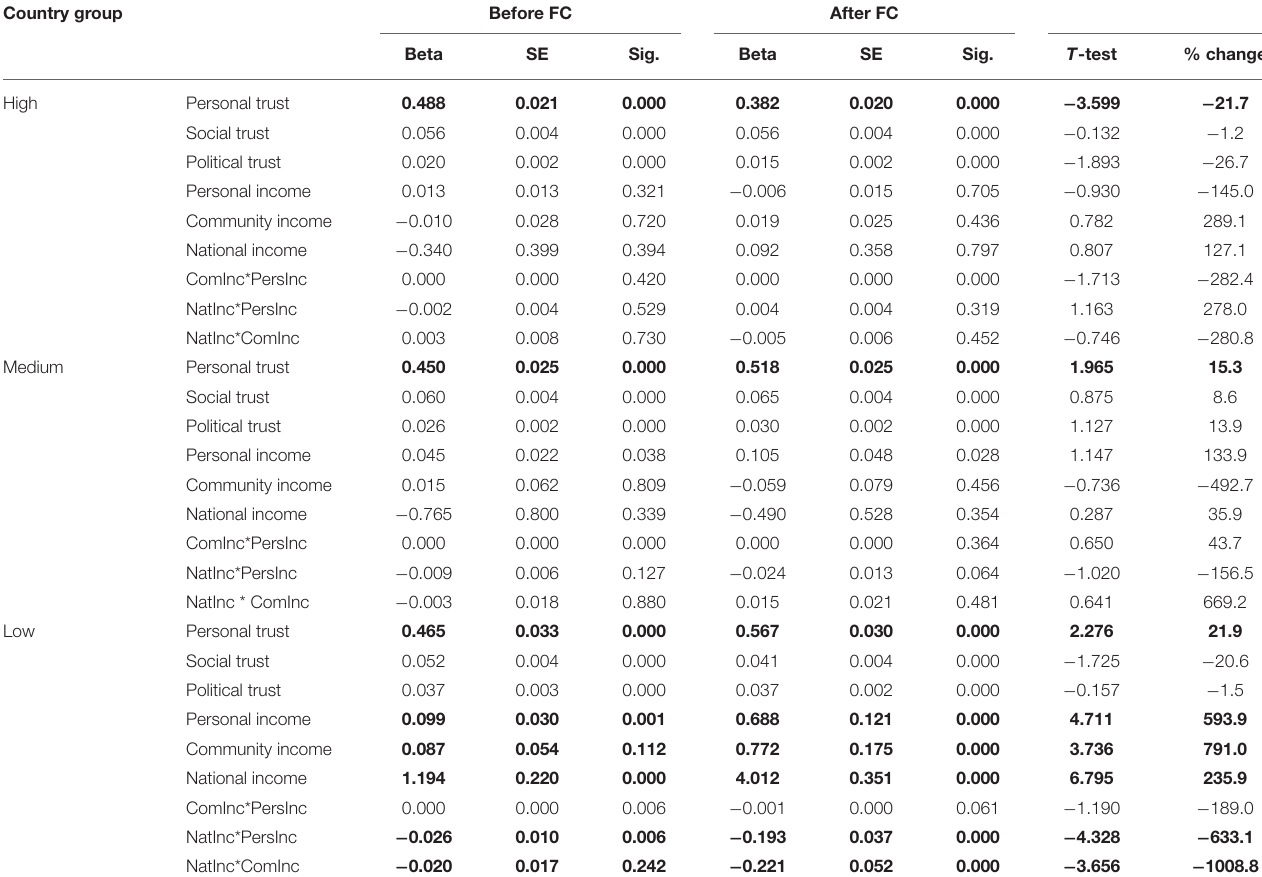
TABLE 4 | Unstandardized beta in a multilevel linear relationship of personal LS, before and after the financial crisis of 2008/2009, as a function of demographic, income, and trust parameters in each of the three groups of countries stratified by an overall trust. Country